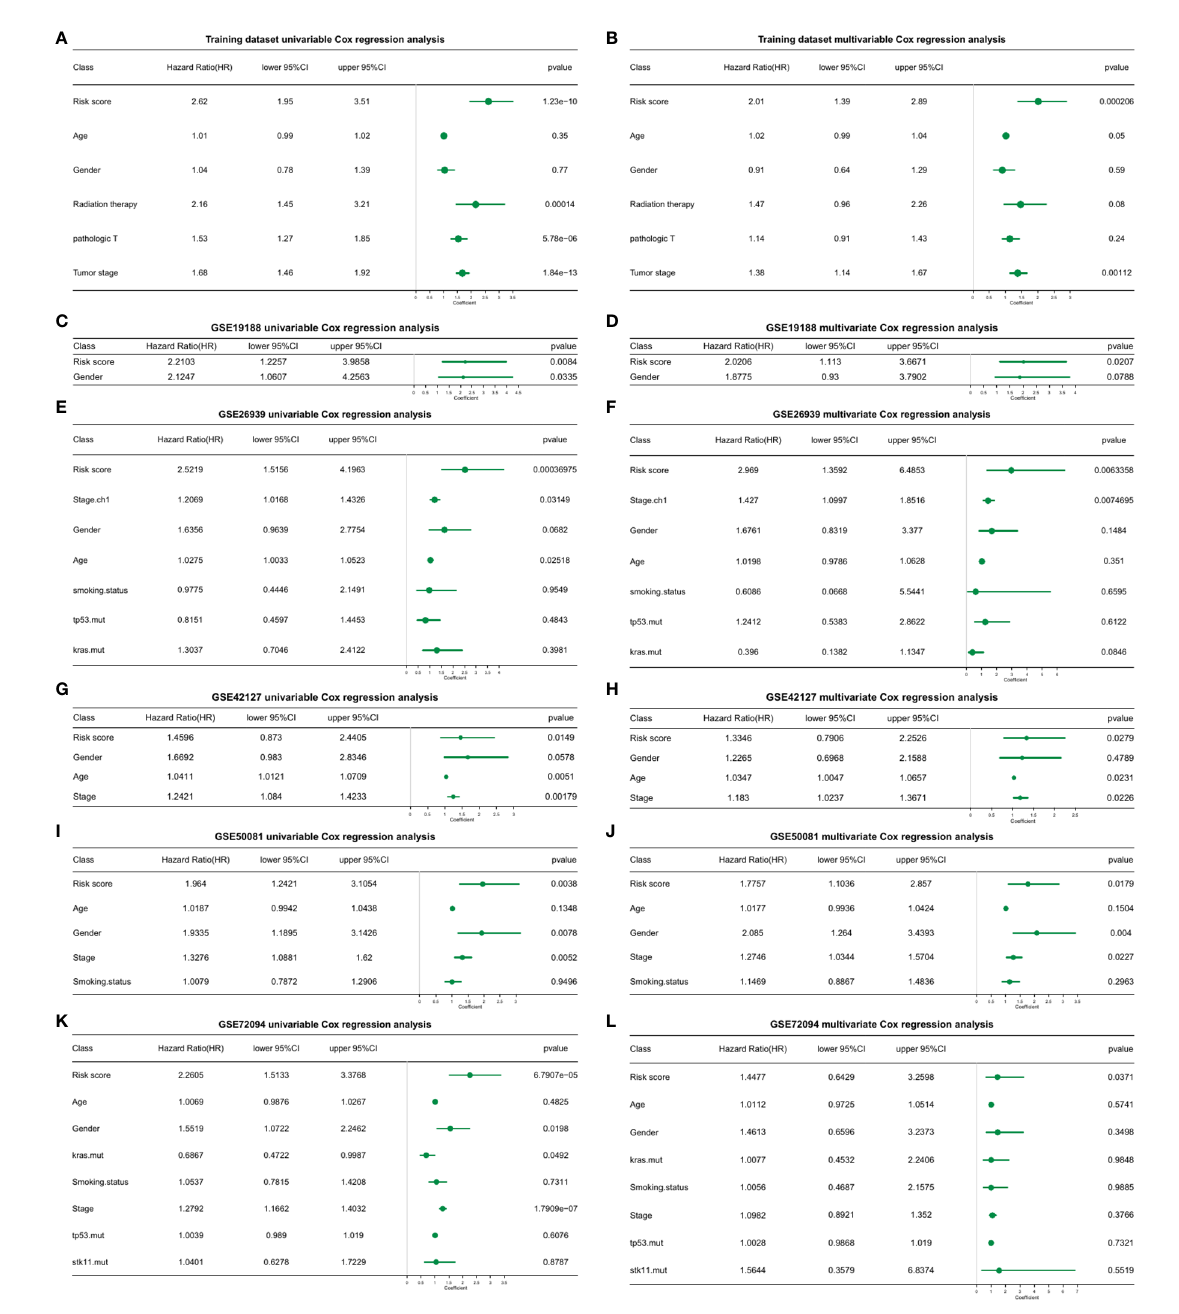
FIGURE 5 Univariate and multivariate cox regression analysis of the risk score model in training and validation datasets. (A) Univariate cox regression analysis. (B) Multivariate cox regression analysis. (C) GSE19188 univariate cox regression analysis. (D) GSE19188 multivariate cox regression analysis. (E) GSE26939 univariate cox regression analysis. (F) GSE26939 multivariate cox regression analysis. (G) GSE42127 univariate cox regression analysis. (H) GSE42127 multivariate cox regression analysis. (I) GSE50081 univariate cox regression analysis. (J) GSE50081 multivariate cox regression analysis. (K) GSE72094 univariate cox regression analysis. (L) GSE72094 multivariate cox regression